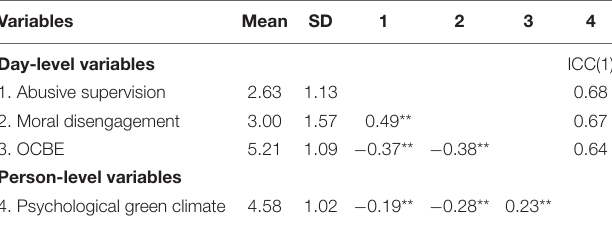
TABLE 1 | Means, standard deviations, and correlations of the between-and within-level variables. Variables